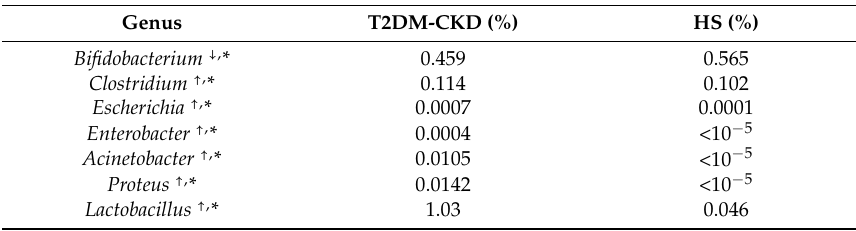
Table 2. The abundance of the gut microbiota identified in the T2DM-CKD patients and healthy subjects (HS), increased ( Ţ ) or decreased ( Ť ). Mann–Whitney U test showed significant difference (*) in Operational Taxonomic Units (OTUs) in the two groups p <